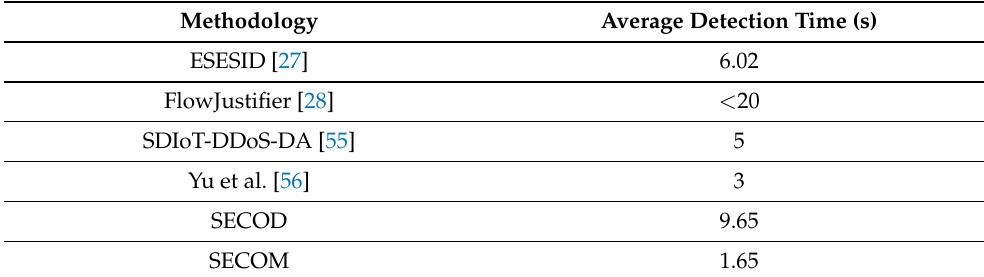
Figure 12. Comparison of detection time using both SECOD (with different monitoring durations) and SECOM algorithms. Table 5. Comparison of Average Detection